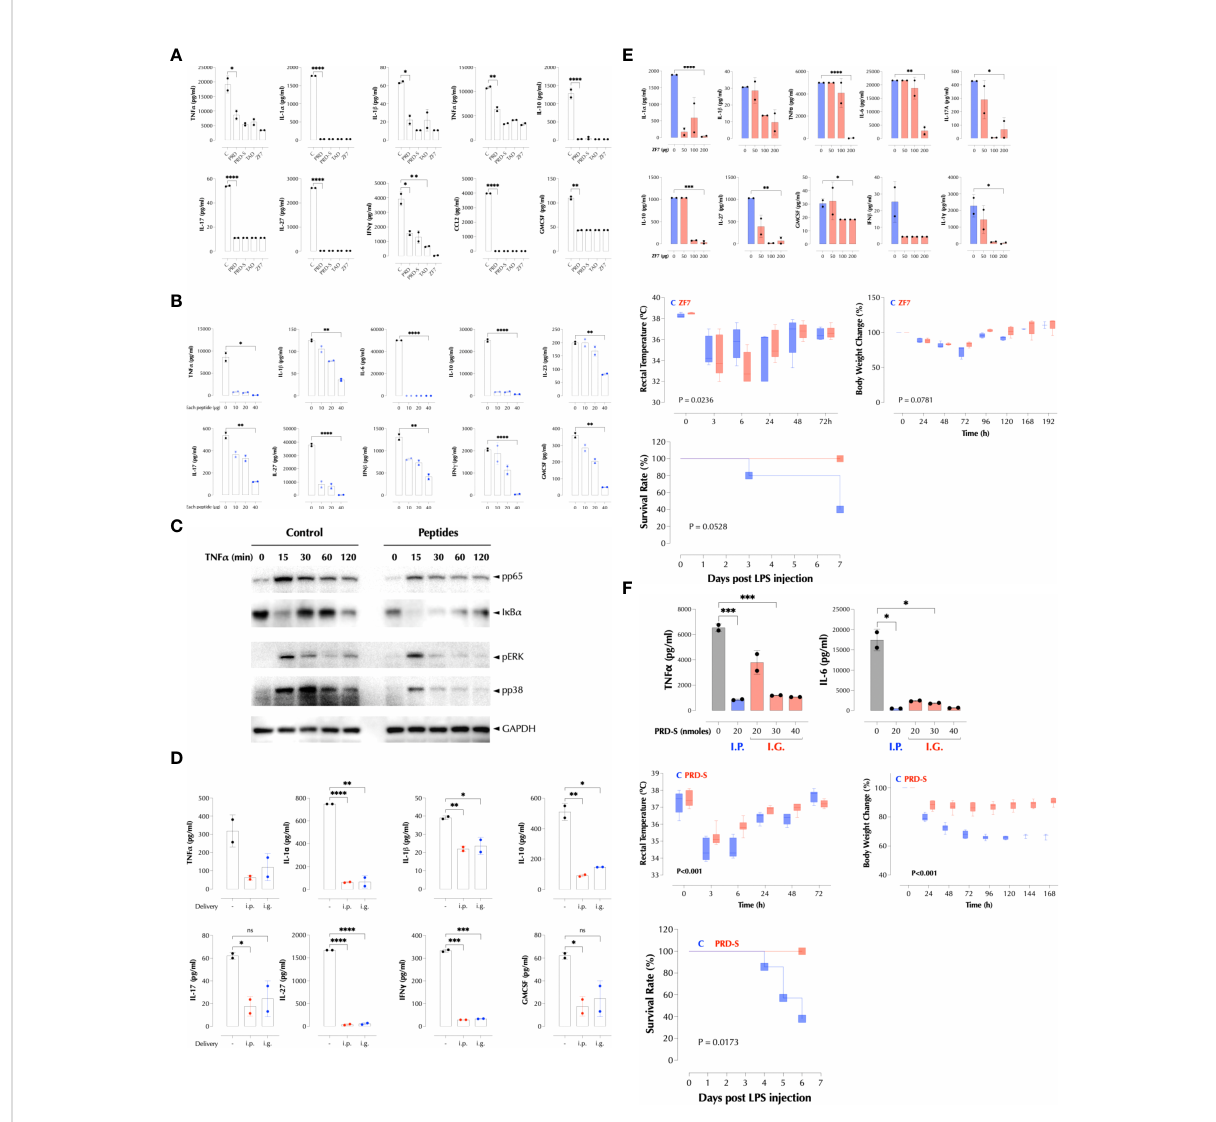
FIGURE 7 PRD, TAD, and ZF7 peptides protect mice from endotoxic injury. (A) PRD, TAD, and ZF7 peptides inhibit the cytokine production by LPS in a dose-dependent manner. C57Bl/6 (n=2) mice were injected i.p with LPS (50µg/mouse) and 20nmoles of each peptide at the same time. The serum cytokine levels were measured 2h post injection by LegendPlex. (B) The combination of PRD, TAD, and ZF7 peptides inhibits the cytokine production by LPS. C57Bl/6 (n=2) mice were injected i.p with LPS (50µg/mouse) and the indicated amount of each peptide at the same time. The serum cytokine levels were measured 2h post injection by LegendPlex. (C) A combination of PRD, TAD, and ZF7 peptides inhibit the TNF signaling. HCT-8 cells were treated with the peptide combination (2µg each peptide/ml) for 30min and stimulated with TNF a (2ng/ml) as indicated. Activation of NF- k B and MAP kinases was measured by western blotting. (D) A combination of PRD, TAD, and ZF7 peptides (40µg each peptide) inhibits the cytokine production by LPS when administered by gavage. C57Bl/6 (n=2) mice were injected with the peptides i.p or i.g. (intragastric) 30min before LPS (50µg/mouse) injection. The serum cytokine levels were measured 2h post injection by LegendPlex. (E) ZF7 peptide protects mice from the LPS-induced cytokines, symptoms, and lethality. Top, C57Bl/6 (n=2) mice were injected i.p with LPS (200µg/ mouse) and the indicated amount of ZF7 peptide, the serum cytokine levels were measured 2h post injection by LegendPlex. Middle, C57Bl/6 (n=6) mice were injected i.p with LPS (200µg/mouse) or LPS + ZF7 peptide (300µg/mouse), and rectal temperature and body weight were measured at the indicated time points. (Statistics, 2-way ANOVA) Bottom, C57Bl/6 (n=6) mice were injected i.p with LPS (200µg/mouse) or LPS + ZF7 peptide (300µg/mouse), and the mortality was monitored for 7 days. (P = 0.0528 by Kaplan-Meier analysis) (F) Oral delivery of PRD-S protects mice from the LPS-induced cytokines, symptoms, and lethality. Top: C57Bl/6 (n=2) mice were injected i.p with LPS (200µg/mouse) and i.p or by gavage the indicated amount of PRD-S peptide (30min before LPS injection), the serum cytokine levels were measured 2h post injection by ELISA. Middle: C57Bl/6 (n=7) mice were injected i.p with LPS (200µg/mouse) or LPS + PRD-S peptide (30nmoles/mouse). PRD-S was administered twice by gavage 30min before and 48h after LPS injection, and the rectal temperature and body weight changes were measured at the indicated time points. (Statistics, 2-way ANOVA) Bottom: The mortality was monitored for 7 days. (P = 0.0528 by Kaplan- Meier analysis). * P < 0.05, ** P < 0.01, *** P < 0.001, ****: 0.0001, ns, not signi fi